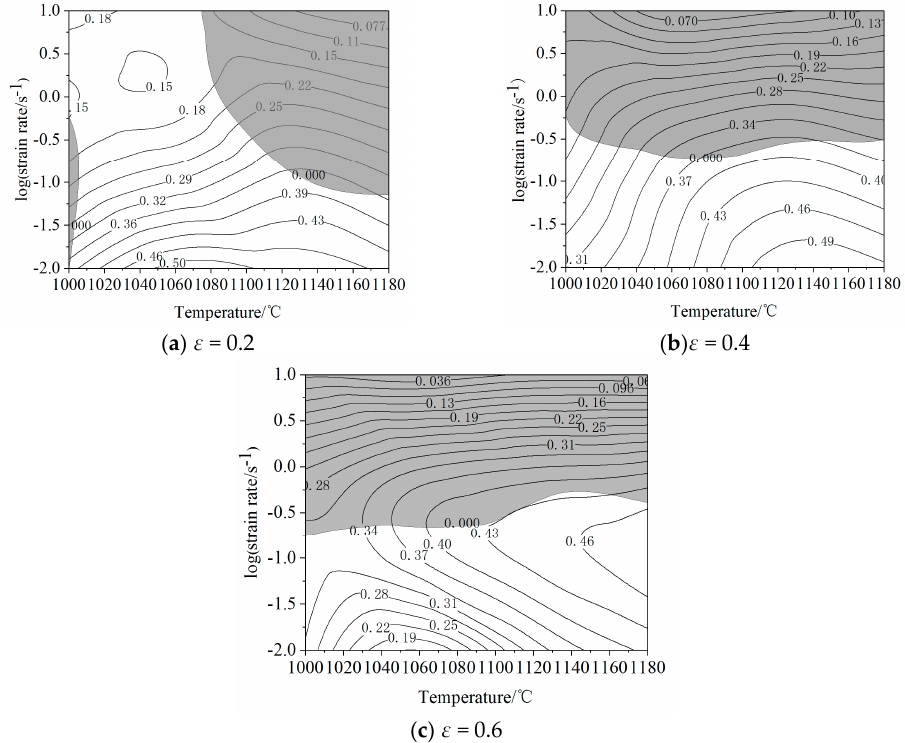
Figure 9. Processing map of 21-4N heat-resistant steel with strains of ( a ) 0.2; ( b ) 0.4; ( c ) 0.6.